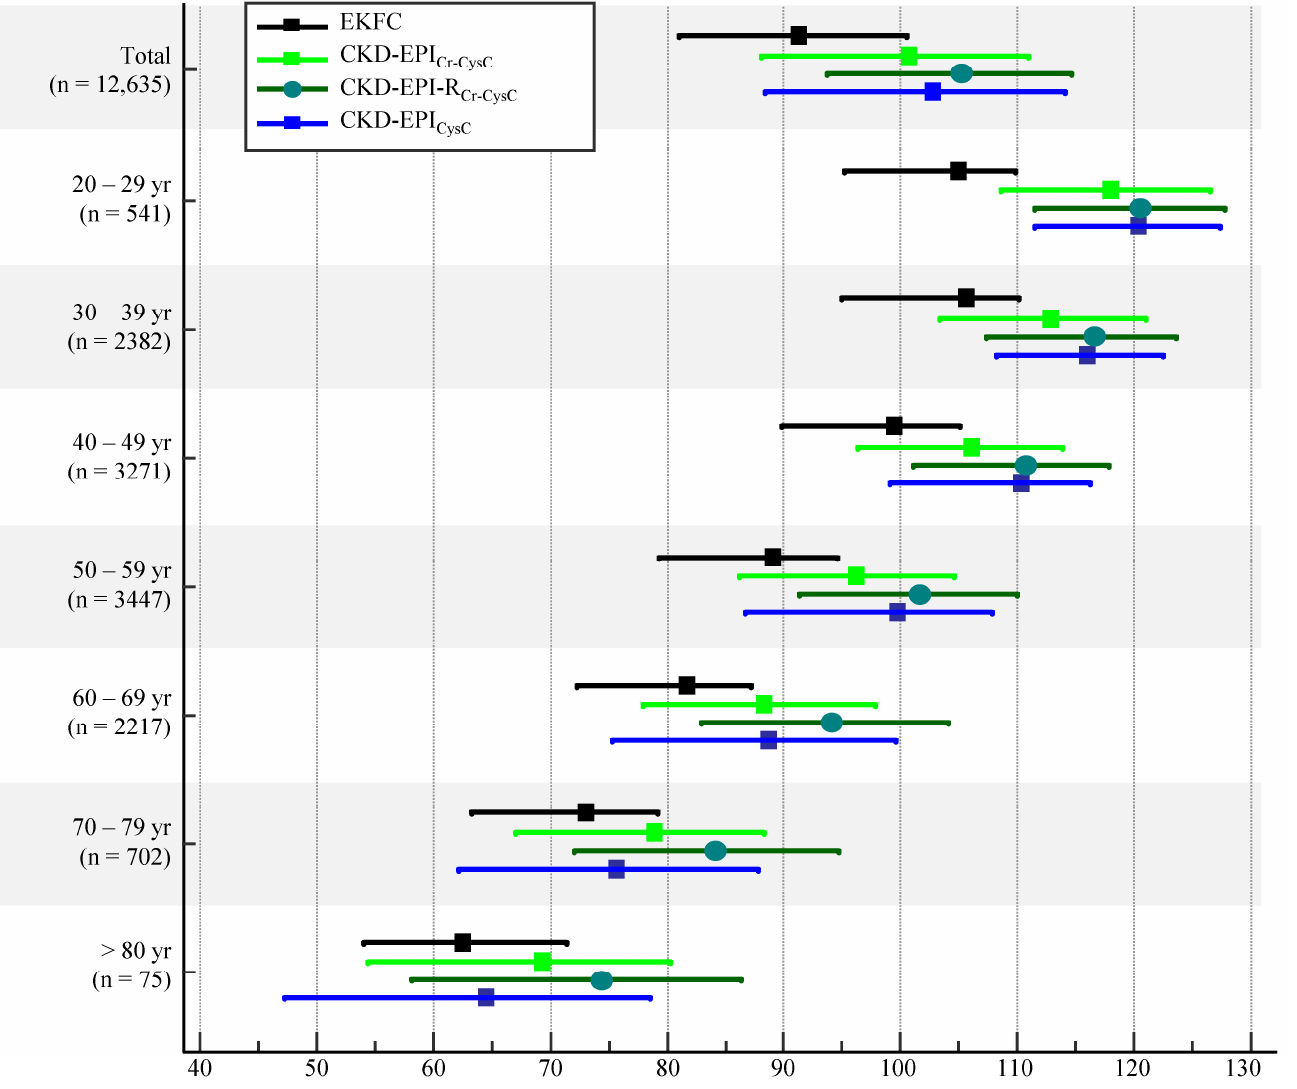
Figure 4. Distribution of eGFR using serum creatinine- and cystatin C-based CKD-EPI, EKFC, and CKD-EPI-R equations stratified by age group. Data are presented as median and interquartile range. Abbreviations: see Table 3. Table 4. Correlation and differences of eGFR among serum creatinine- and cystatin C-based CKD- EPI, EKFC, and CKD-EPI-R equations stratified by age group.